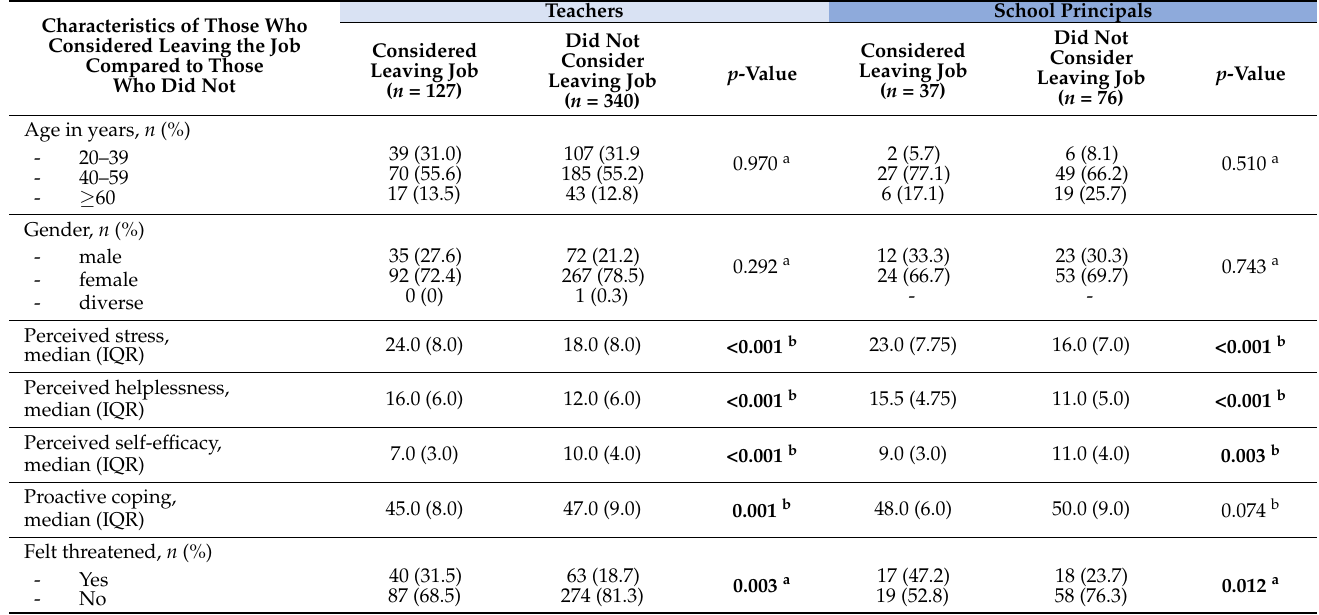
Table 6. Characteristics of teachers and school principals who considered leaving their job compared to those who did not.